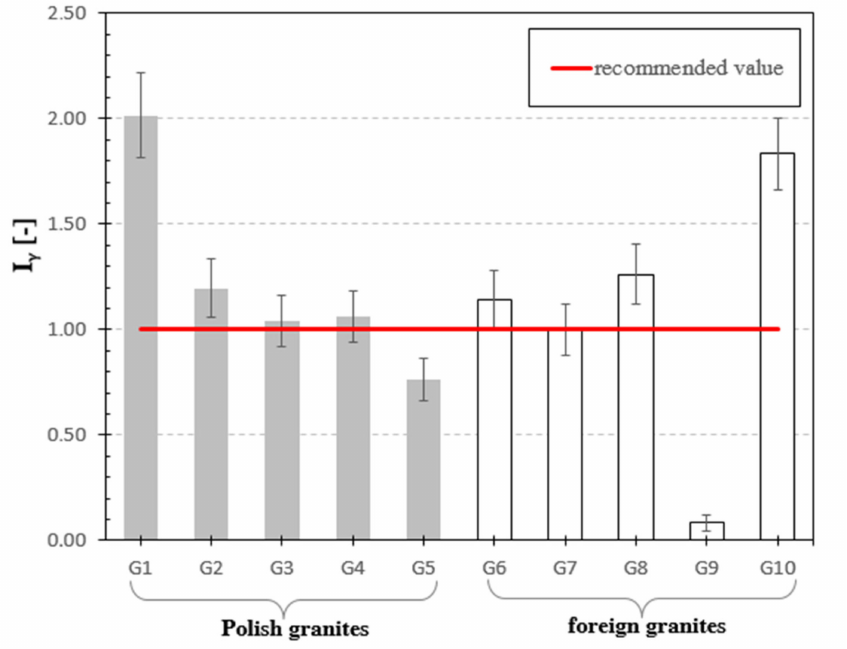
Figure 11. Gamma index for analyzed granite samples. The horizonal line indicates the recommended value of I γ equal to 1 [24] for natural stones.